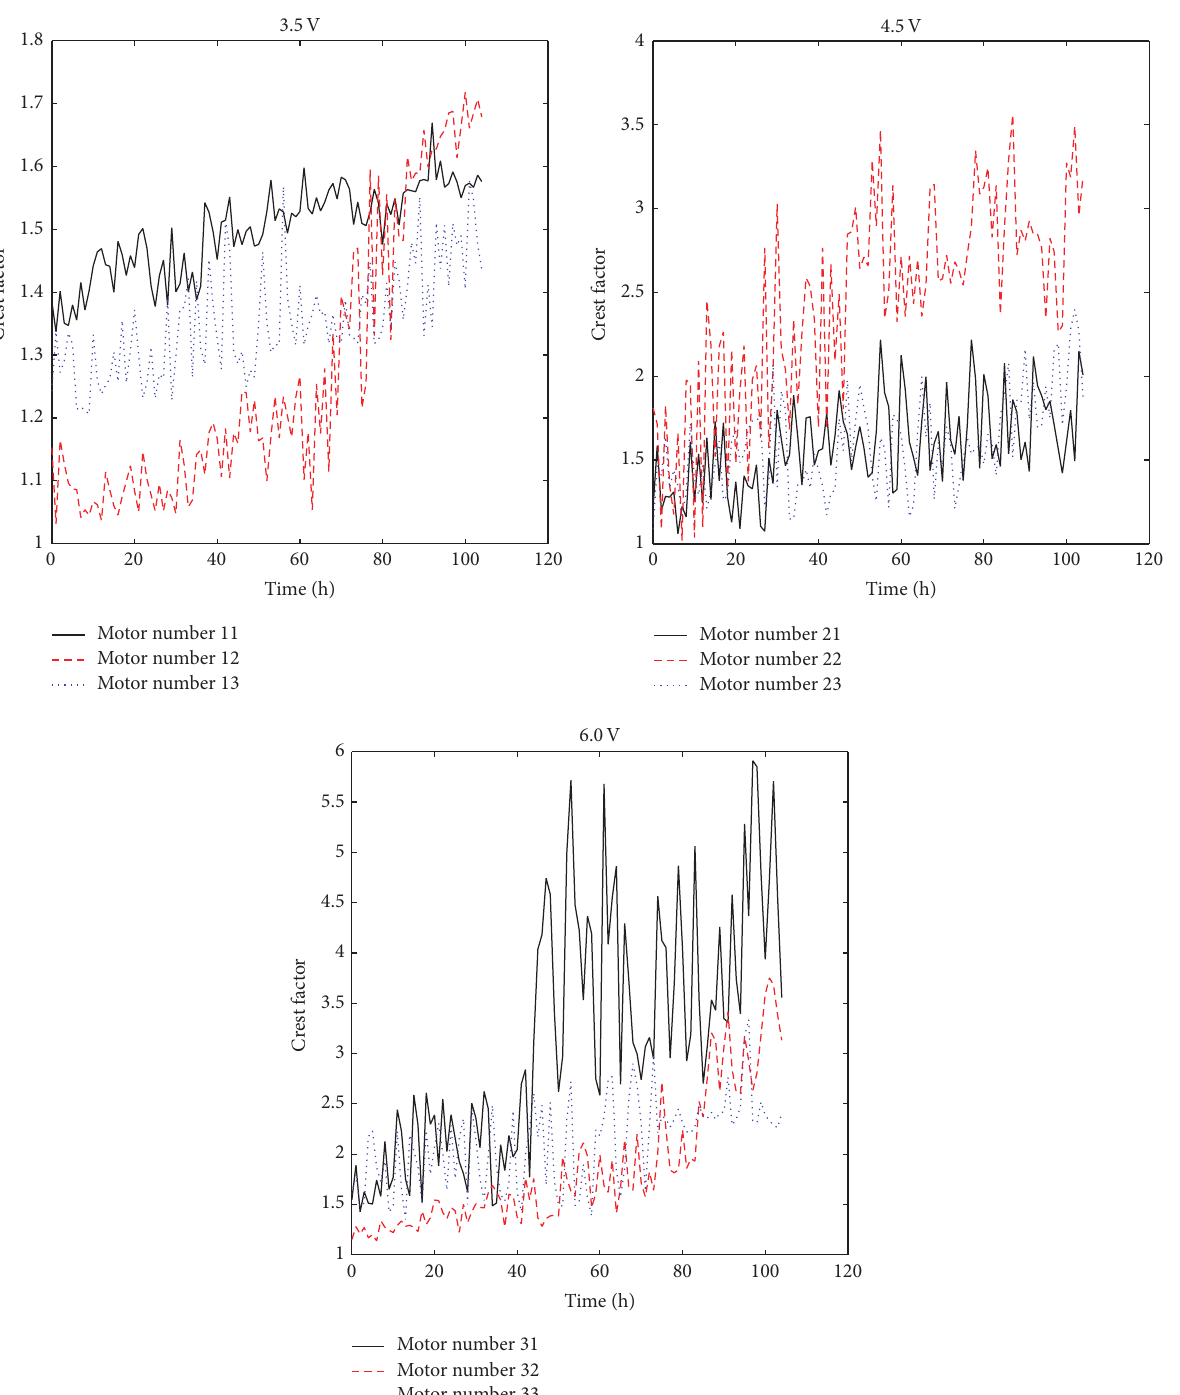
Figure 6: The CSADT data of crest